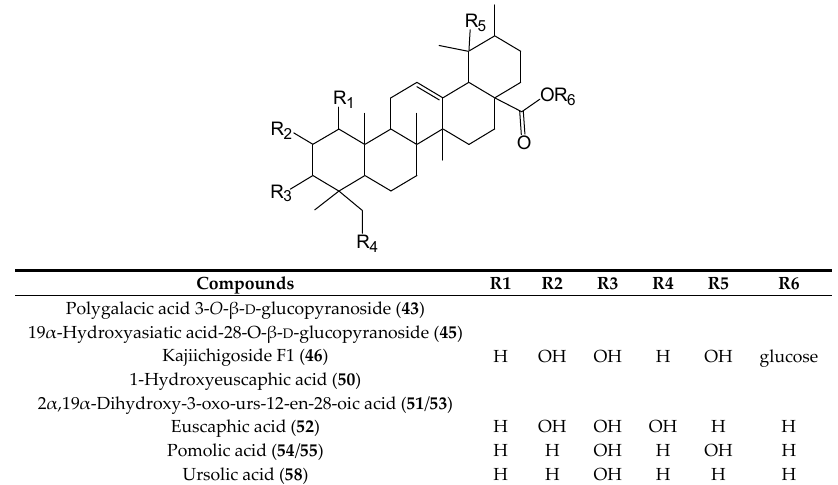
Figure 4. Chemical structures of compounds identified in the methanol extracts of R. roxburghii and R. sterilis fruits.